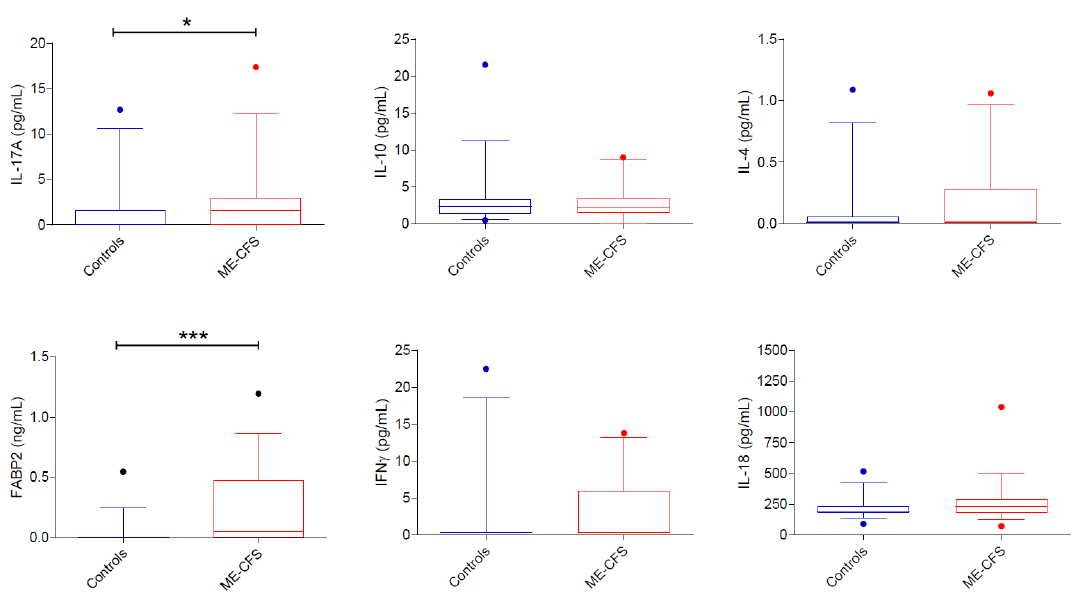
Figure 2. Case-control comparison of serum cytokines and FABP2 ( n = 9). Serum IL-17A and FABP2 levels are higher in ME/CFS patients than in controls. Data are presented as boxplots with median and interquartile ranges and 5–95 percentiles. Black dots represent data outside the 5 – 95 percentiles. * p < 0.05 and *** p < 0.001; Quade’s rank analysis of covariance with BMI, sex, and age as covariates.